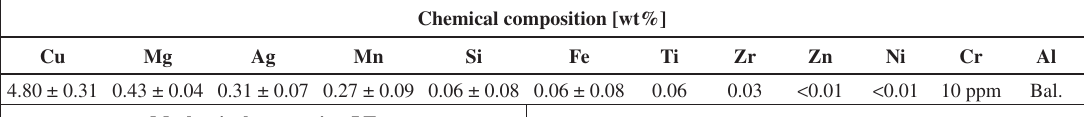
Table 1. Chemical composition and mechanical properties of AA2139 (median over four specimens, the 80% confidence limits are reported). Chemical composition